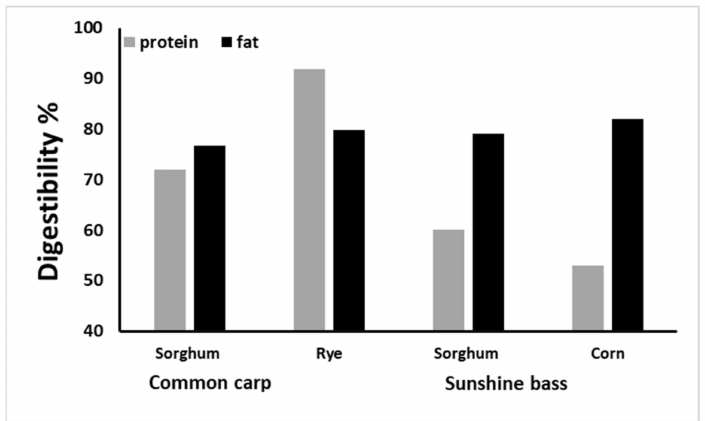
Figure 3. A comparison between sorghum and corn and rye nutrient digestibility in common carp [88] and Sunshine bass